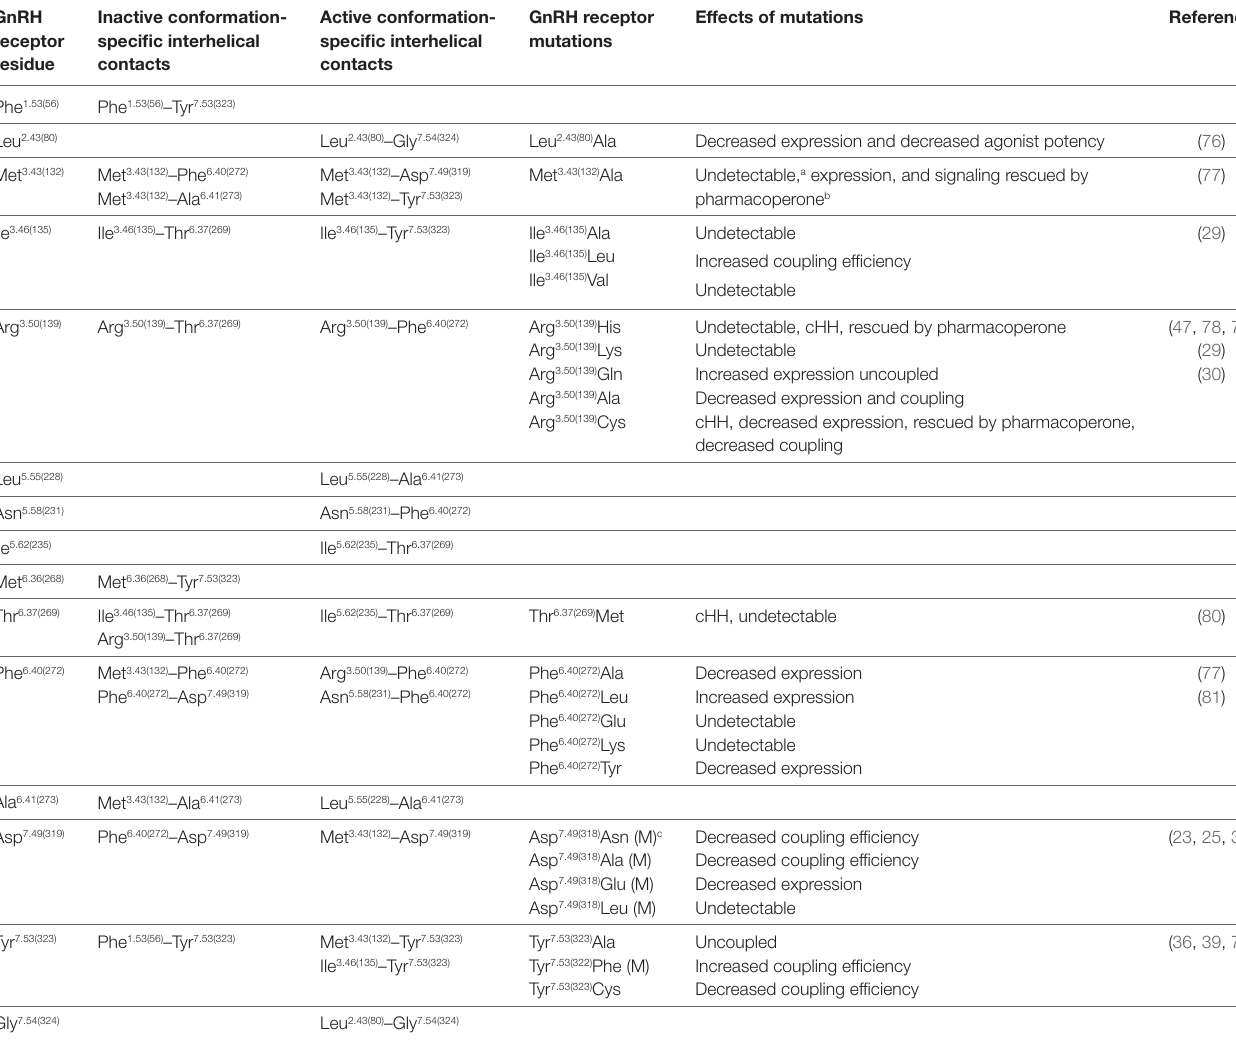
TABle 2 | GnRH receptor residues potentially involved in conserved conformation-specific interhelical